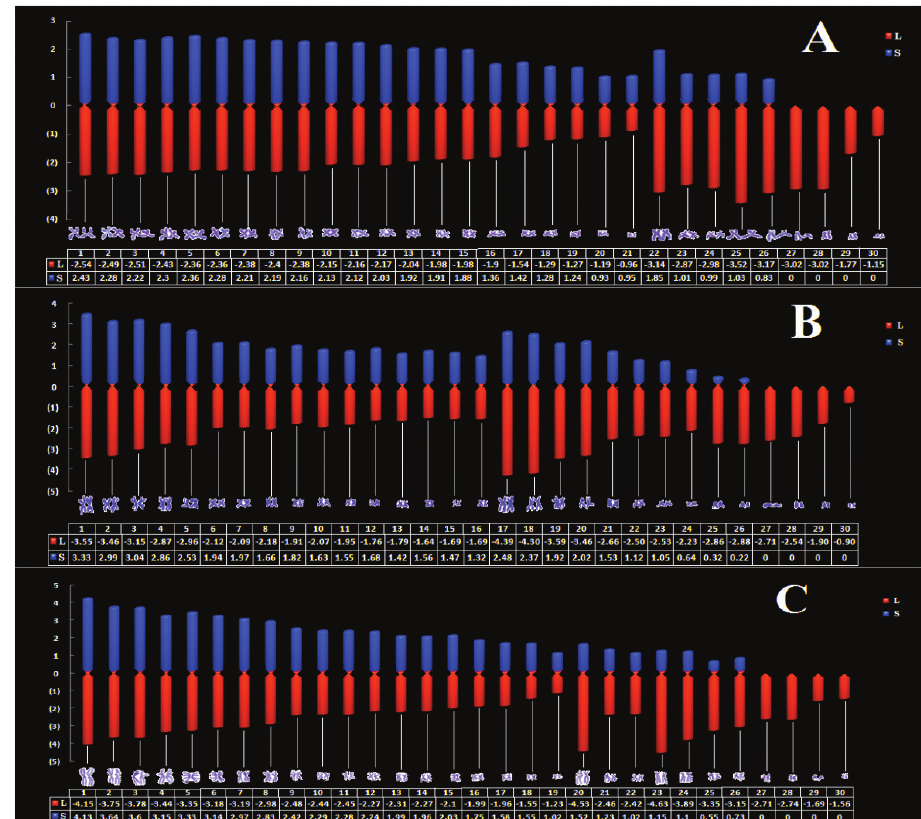
Figure 2. A novel display method of karyo-idiograms. Three octopods are shown: A O. minor B A. fangsiao C C. chinensis . The blue columns are the short arms and the red columns are long arms. Nicks mark the